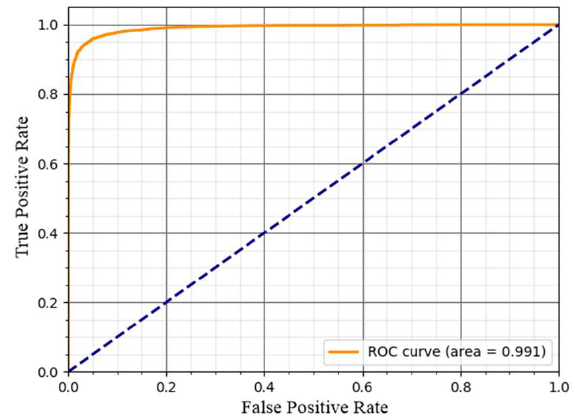
Figure 5. ROC-curve of the classifier of model 12.